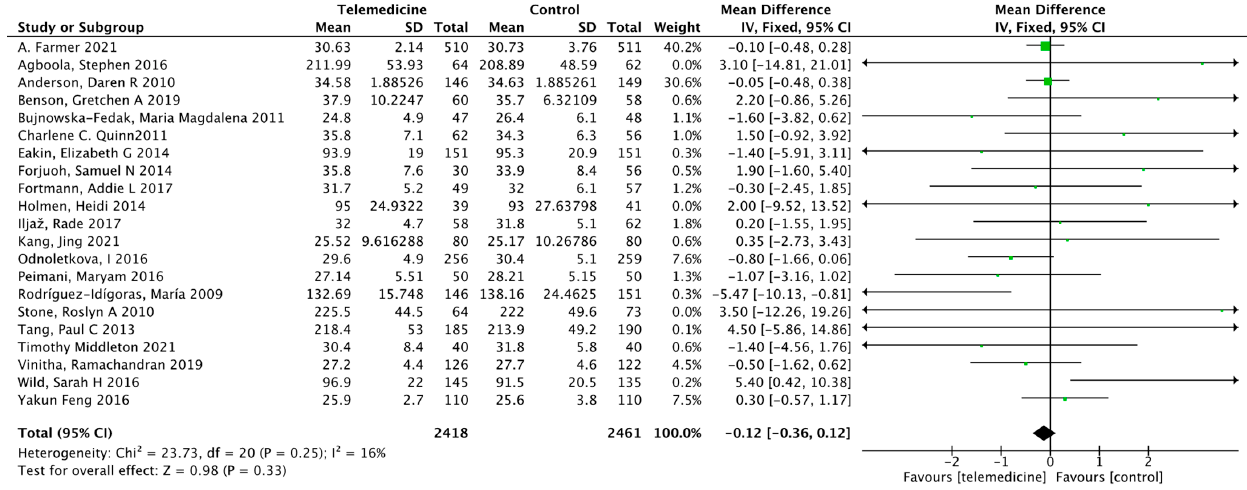
Figure 8. Mean difference in the changes in weight levels for telemedicine and usual care interven- tions.